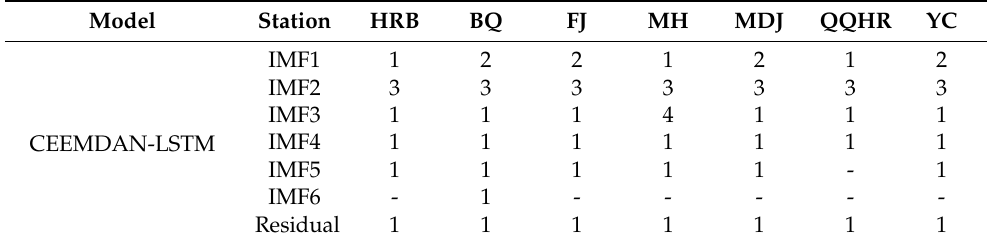
Table 3. The maximum autocorrelation order of each IMF and residual series of the break-up date series of each hydrological